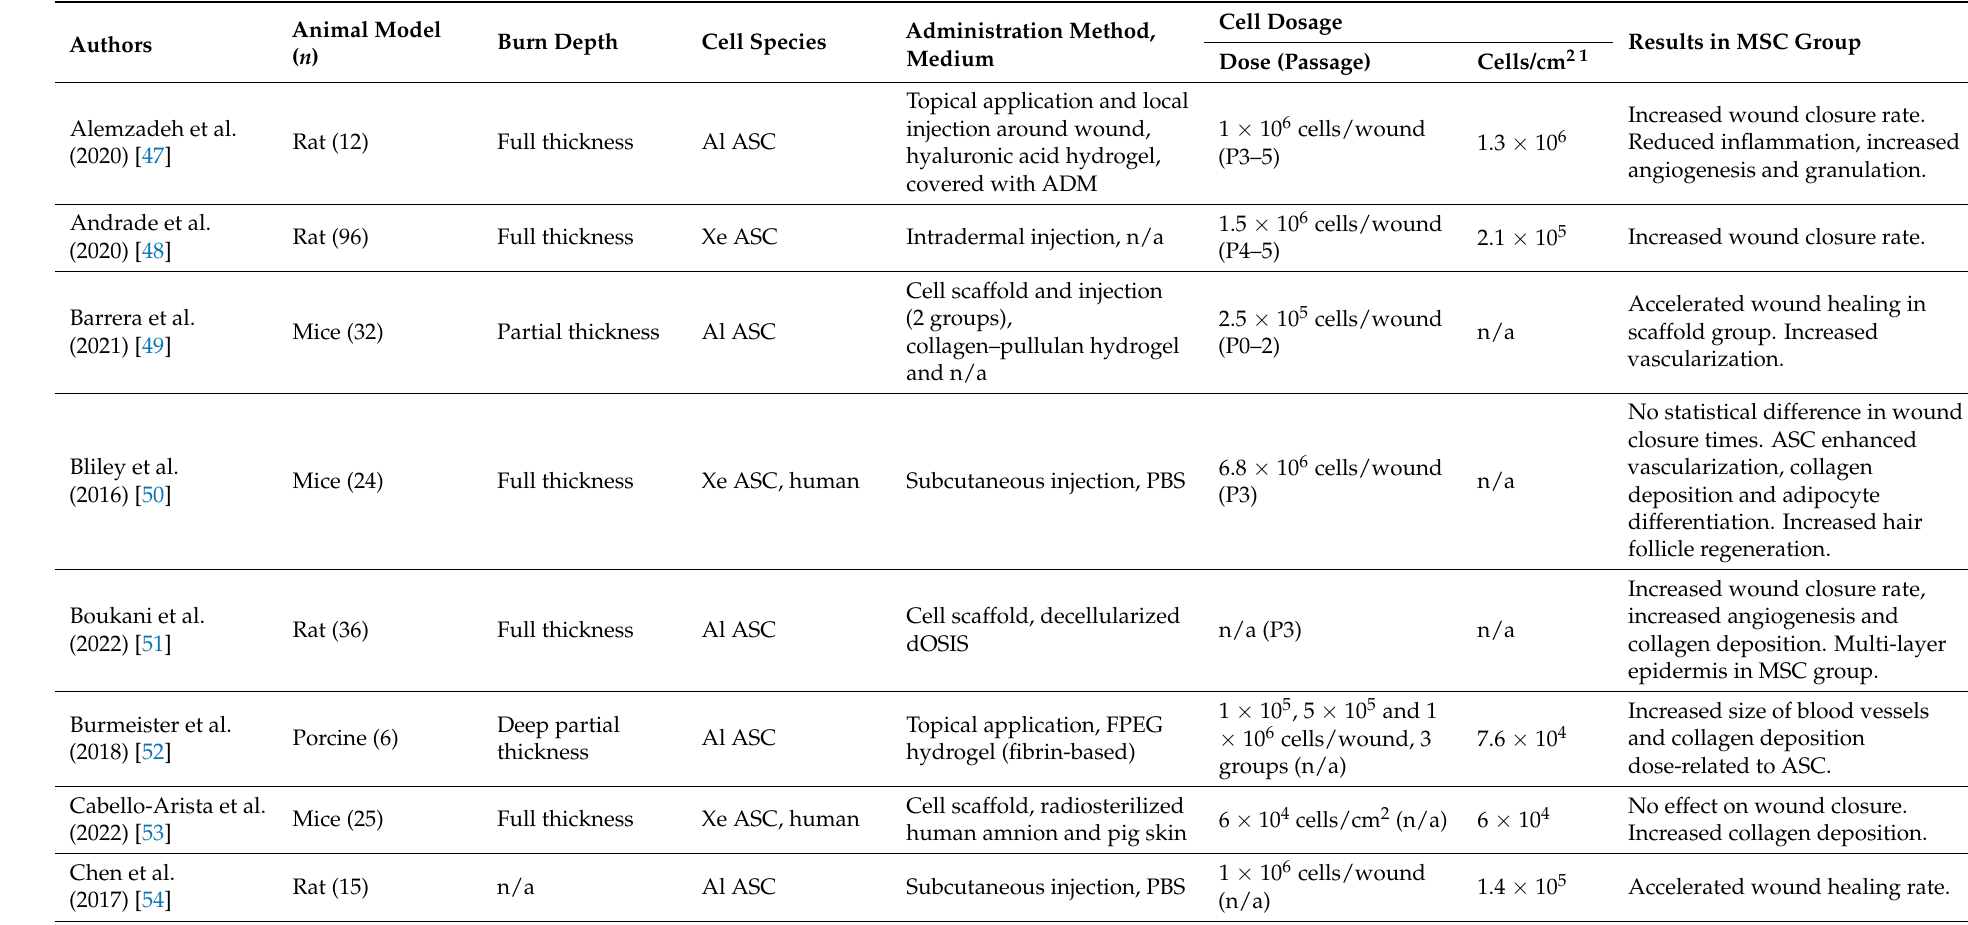
Table 4. Characteristics of studies included—preclinical studies using adipose-tissue-derived MSCs ( n =